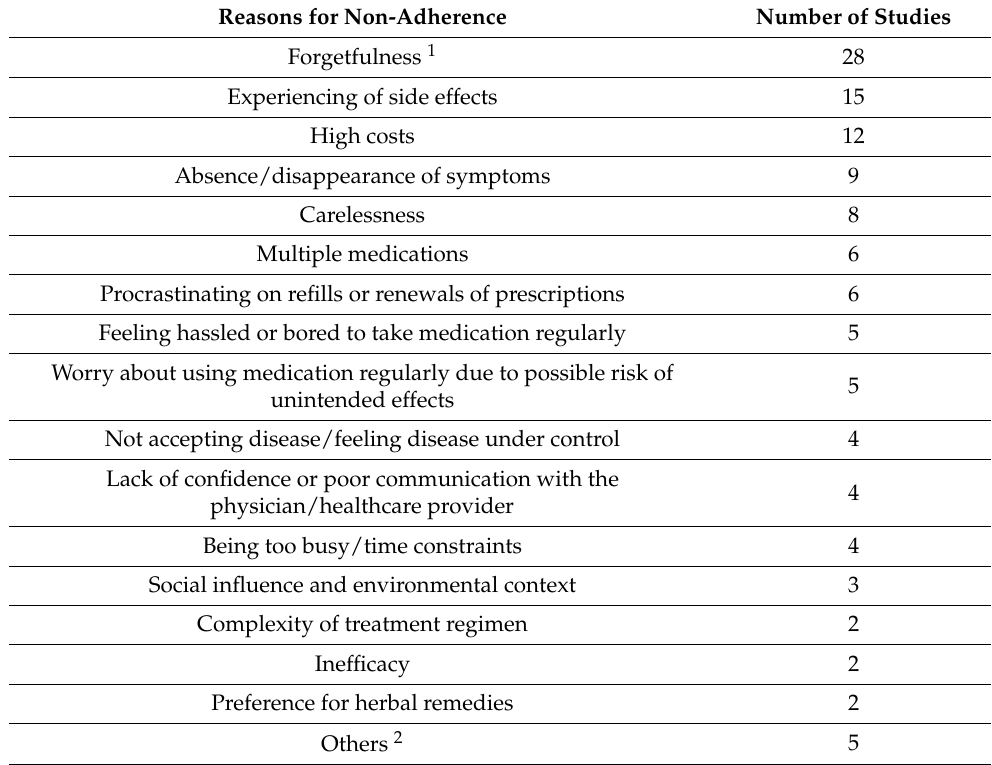
Table 2. Most reported reasons for non-adherence (barriers to adherence). 1 : also includes forgetful- ness due to events that disrupt the routine of taking medicine as prescribed (i.e., being away for long time, having someone at home, being at restaurant, travelling). 2 : problems in following the treatment plan, ignorance of life-long drug adherence, non-awareness of the chronic nature of diabetes, dislike of the taste of the medication, difficulty in swallowing due to the size of